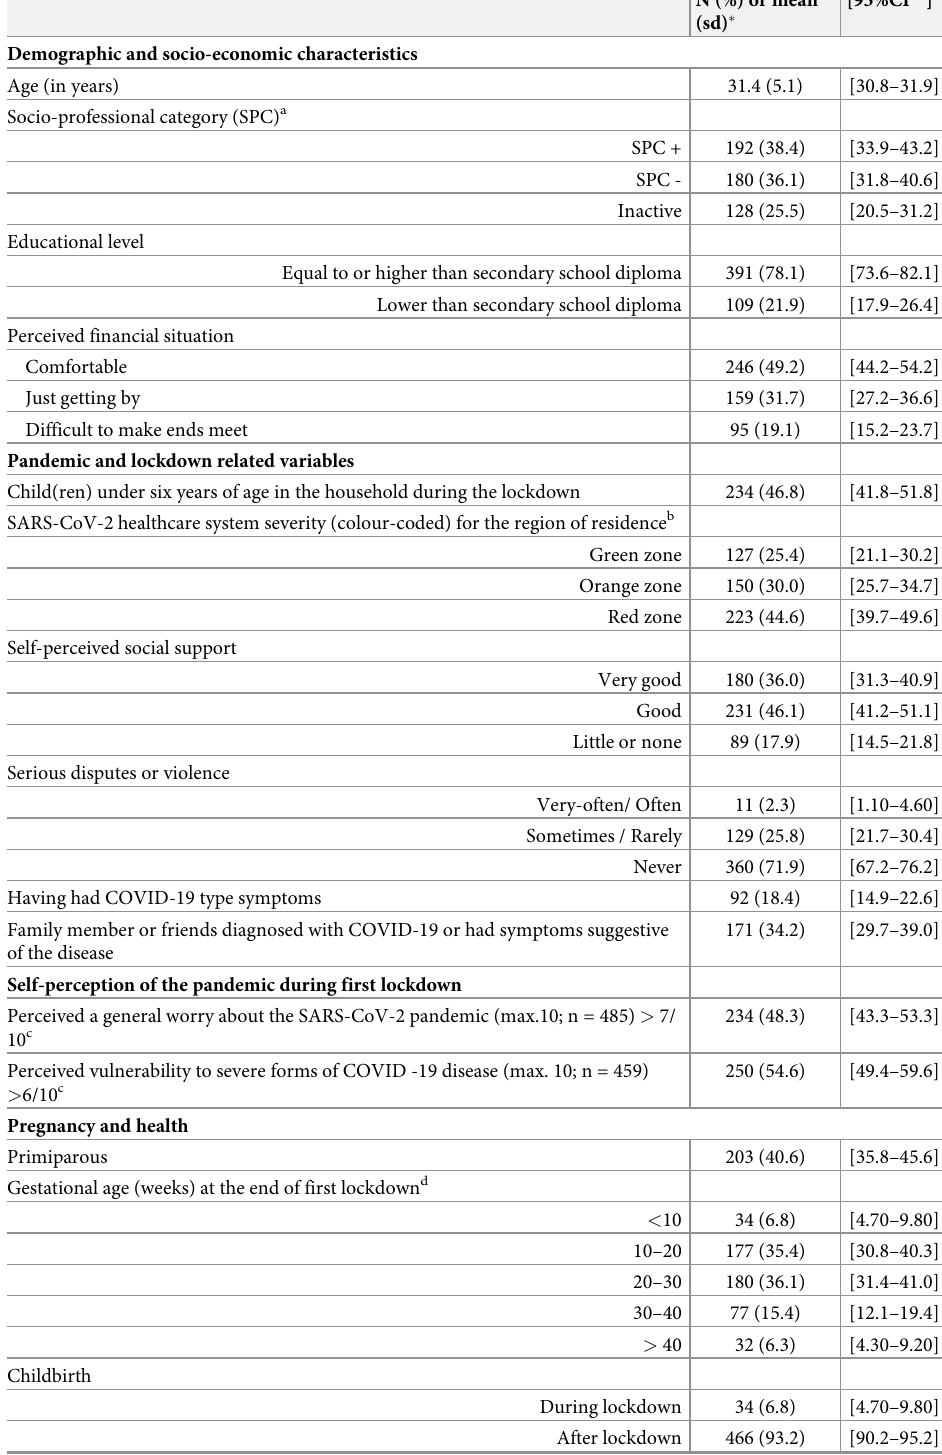
Table 1. Description of pregnant women during the first COVID-19-related lockdown (March to May 2020) who participated in the Covimater survey (n = 500), France (July